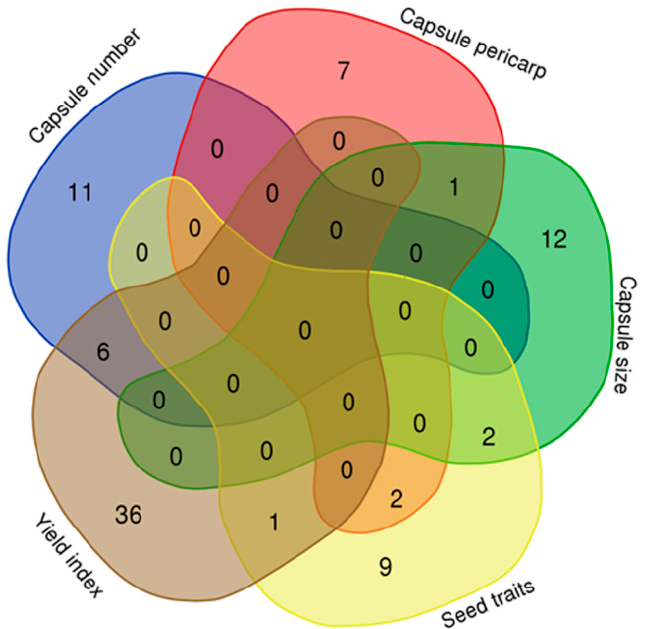
Figure 4. Venn diagram depicting the shared and common QTLs between five groups of seed yield-related traits analyzed in this study.